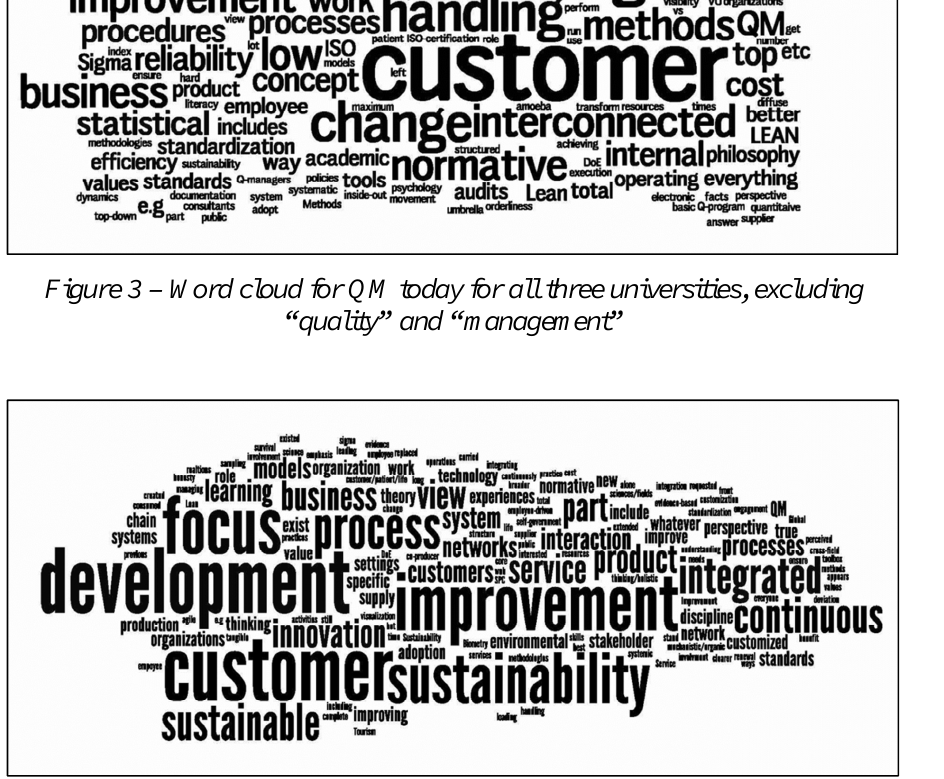
Figure 4 – Word cloud for QM in 20 years for all three universities, excluding “quality” and